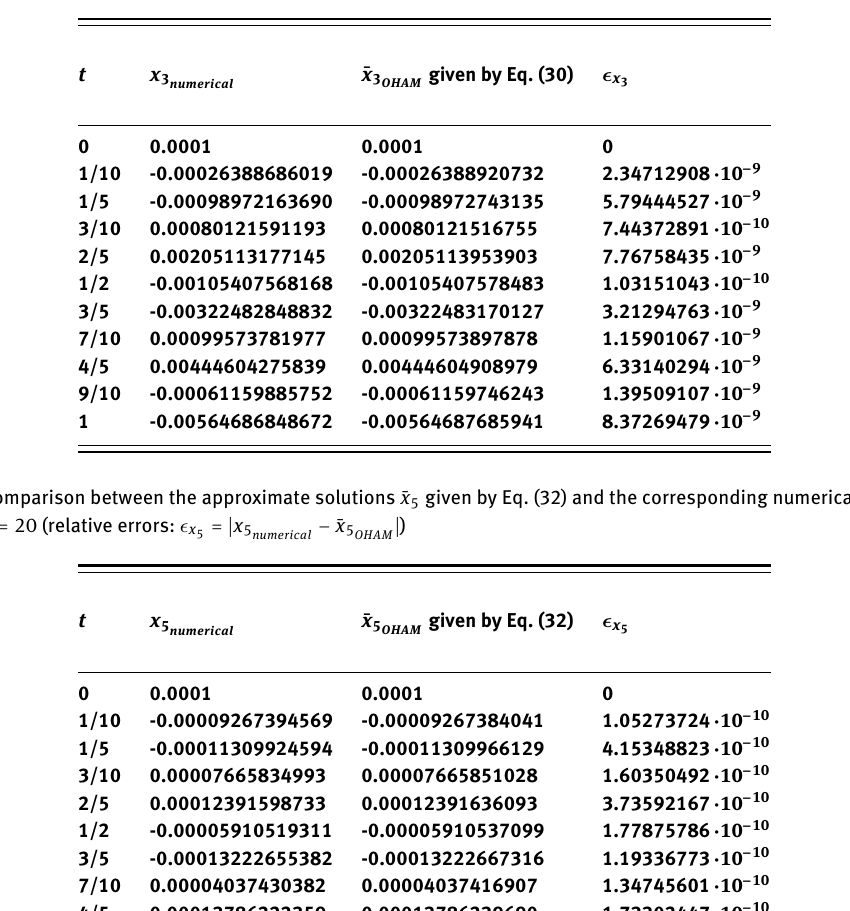
= ∣ x 3 − ¯ x 3 ∣ ) 3 OHAM numerical